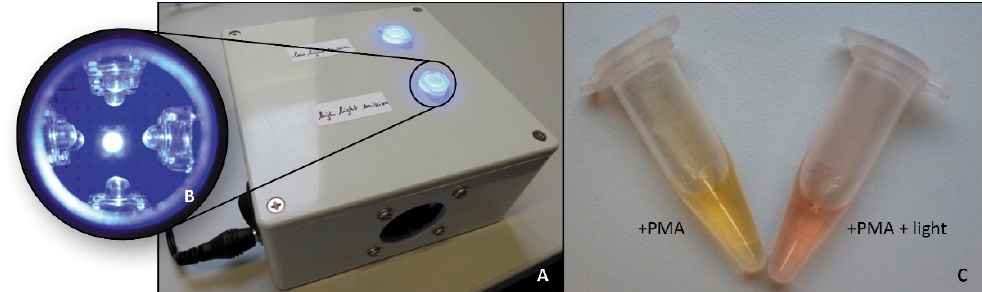
Figure 2. In-house constructed photoactivator for covalent binding of the photoactive dye PMA to accessible DNA from heat killed bacteria ( A ). The LED diodes allow for high or low blue light emission ( A , B ). Exposure of blue light to a PMA containing solution leads to a color change from yellow (only PMA without light) to red (PMA + light) ( C ).